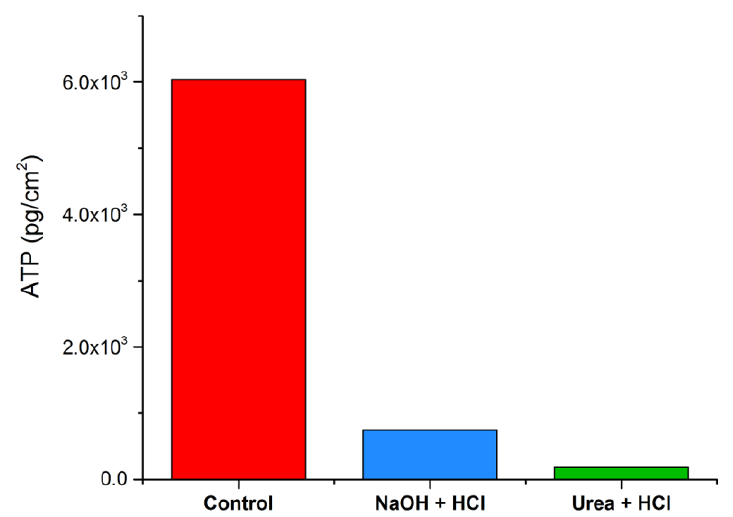
Figure 4. Concentration of active biomass measured as pg ATP/cm 2 in the control (uncleaned) and cleaned membrane modules.